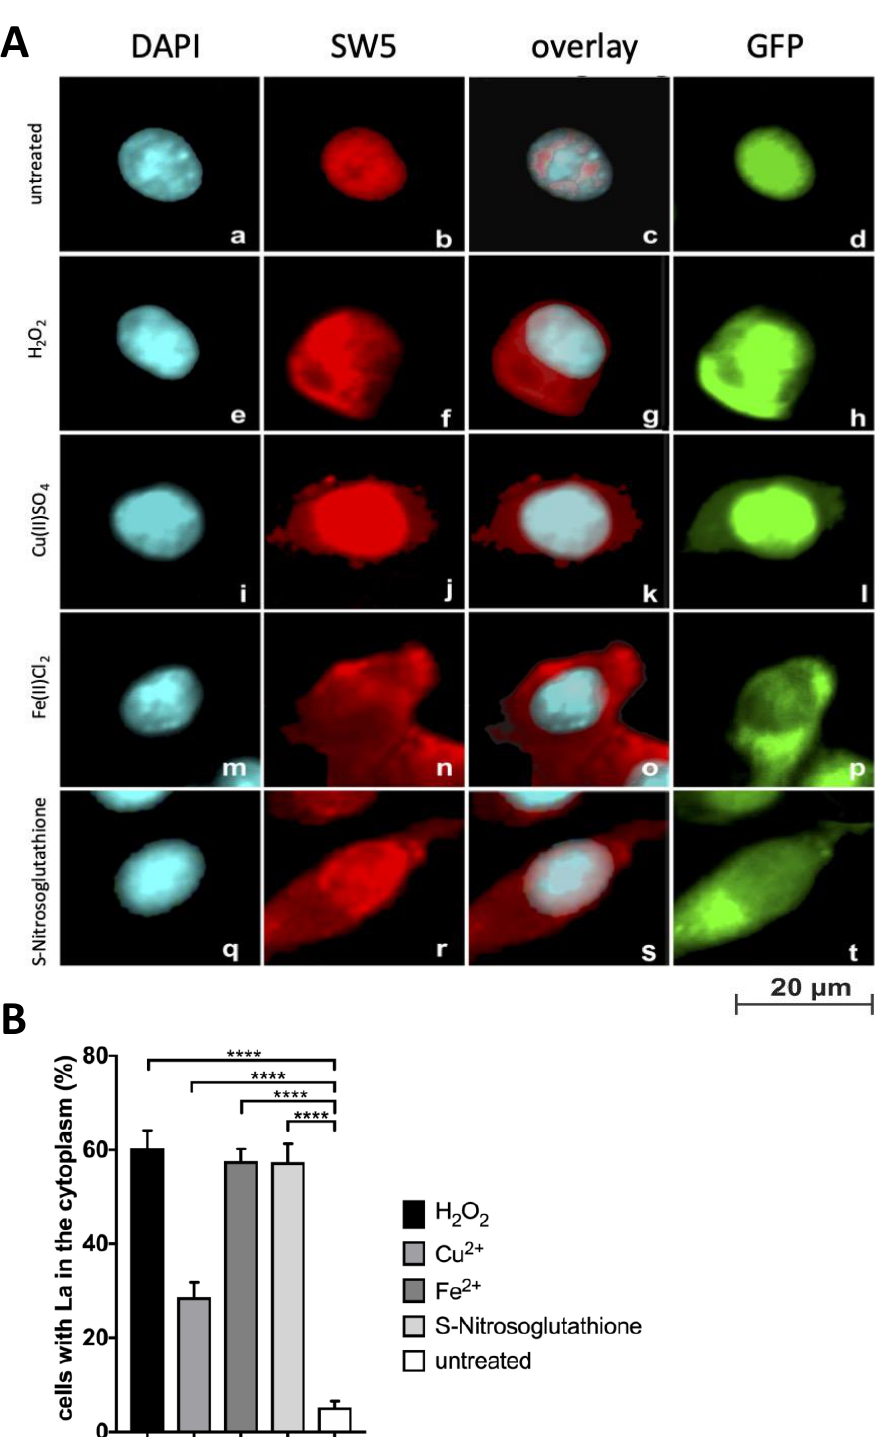
Figure 4. Translocation of La protein to the cytoplasm and its dependence on oxidative conditions. (A) Immunofluorescence analysis. ( a – d ). Untreated mouse 3T3 cells overexpressing His-La-GFP. ( e – h ) Cells treated with H 2 O 2 or ( i – l ) CuSO 4 , or ( m – p ) FeCl 2, or ( q – t ) S-Nitrosoglutathione. Fixed cells were stained with ( a , e , i , m , q ) DAPI or ( b , f , j , n , r ) the anti-La mAb SW5. Overlay of DAPI and SW5 staining ( c , g , k , o , s ) as well as GFP fluorescence ( d , h , l , p , t ). ( B ) Quantitative evaluation of the percentage of cells showing cytoplasmic staining comparing untreated cells with cells after the respective treatment. p Value < 0.0001 = ****.